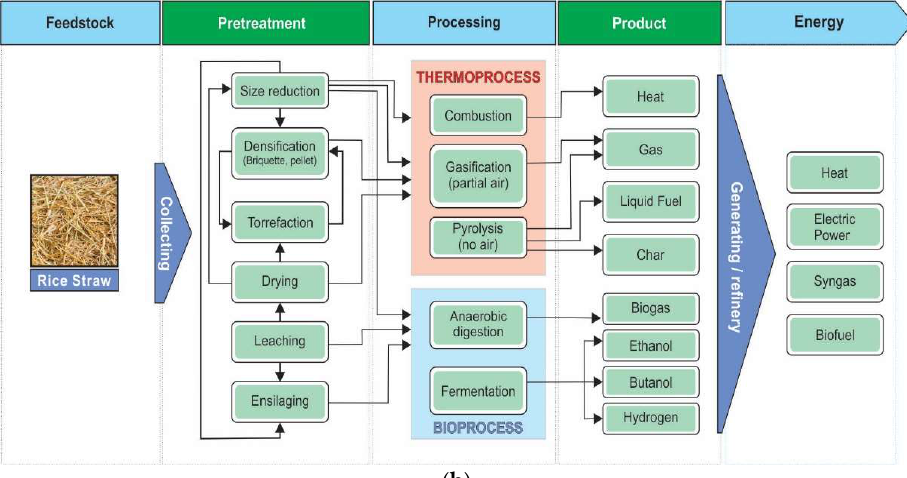
Figure 2. The potential application of ( a ) rice husk and ( b ) rice straw for fuel and power generation. Kadam et al. [49] stated that for every ton of rice grain obtained, there is at least 1.35 tons of rice straw residue remaining in the fields. Therefore, looking at the paddy production reported in previous studies, it becomes clear that the amount of agricultural rice straw residue produced is extremely high. According to Zhiqiang Liu [50], rice straw waste represents about 62% of the rice production in China, and it is not utilized properly for energy generation. In Taiwan, during 2007, based on the paddy field area of 9375 ha, around 0.0563 million tons of wet and fresh rice straw remained at farms following the rice harvest. The total planted area was 38,862 ha, producing up to 0.233 million tons of rice straw [51]. Different researchers have reported different residue ratios of rice straw and rice husk, varying from 1.0 to 3.96 and 0.2 to 0.33, respectively. Table 1 shows the rice crop, rice straw, and rice husk production of the top 20 rice-producing countries. Globally, 769.75 million tons of rice straw and 153.95 million tons of rice husk was produced in 2017, which could have been used to produce 638.03 PJ of energy [38]. Table 1. Rice crop, rice straw, and rice husk production in the top 20 rice-producing countries in 2017 [52]. Rice Crop Predicted Rice Predicted Rice Energy Countries (million tons) Husk a Straw b Potential